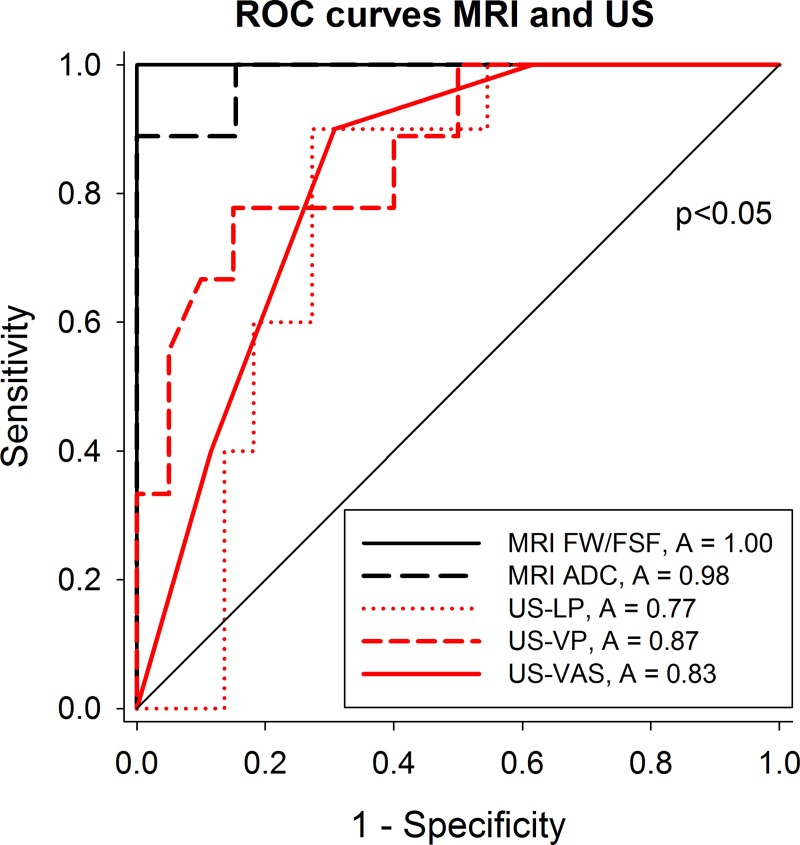
Receiver operator (ROC) curves for all US and MRI parameters for the prediction of exocrine pancreatic insufficiency yielded significantly better AUC for the MRI parameters (A: Area under ROC) than for the US parameters.The p value <0.05 refers to the significantly higher AUC for the MRI parameters compared to that of US-LP and US-VAS. The AUCs for the MR parameters only tended to be higher than that of US-VP (p = 0.07). ADC: Apparent diffusion coefficient, FSF: Fat-signal fraction, FW: Fat water ratio, LP/VP: Liver/pancreas and Vessel/ pancreas echo intensity ratios, MRI: Magnetic resonance imaging, US: Ultrasonography.